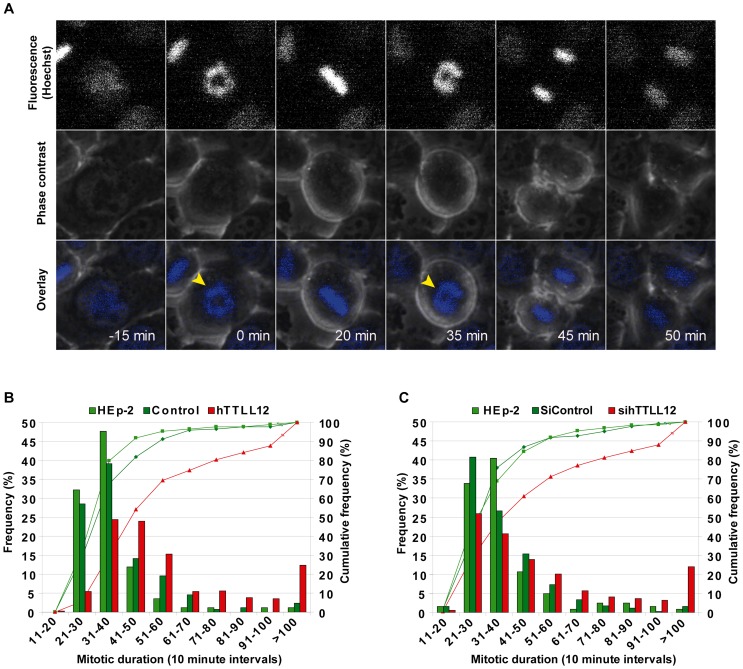
hTTLL12 up and down regulation prolong mitotic duration of HEp-2 cells.
A. Example frames from live cell movies of a HEp-2 cell stained with vital Hoechst. The time between nuclear envelope breakdown (NEB, first arrowhead, 0 min) and anaphase onset (second arrowhead) are indicated. Upper panel: fluorescent images (Hoechst), middle panel: phase contrast images, lower panel: overlay. B–C. Cumulative frequency (plot, right axis) and frequency distribution (histogram, left axis) of mitotic duration for hTTLL12 clones (B) and siRNA transfected HEp-2 (C). B. hTTLL12 (hTTLL12_A-E) or Control (Control_A-E) clones were seeded in 6-well plates. 48 hours post seeding, cells were treated with vital Hoechst and analysed (Experimental Procedures). Parental HEp-2 cells (light green), and the averages of the hTTLL12 (red) and Control (dark green) clones are plotted. C. HEp-2 cells were transfected separately with 12.5 nM sihTTLL12_1-6 or controls (siLuciferase, siCtrl, siScramble). 72 hours post transfection, cells were stained with vital Hoechst and analysed. HEp-2 cells; light green; averages of sihTTLL12s; red; averages of siControls; dark green. More detailed information and statistical analysis can be found in Figure S1.